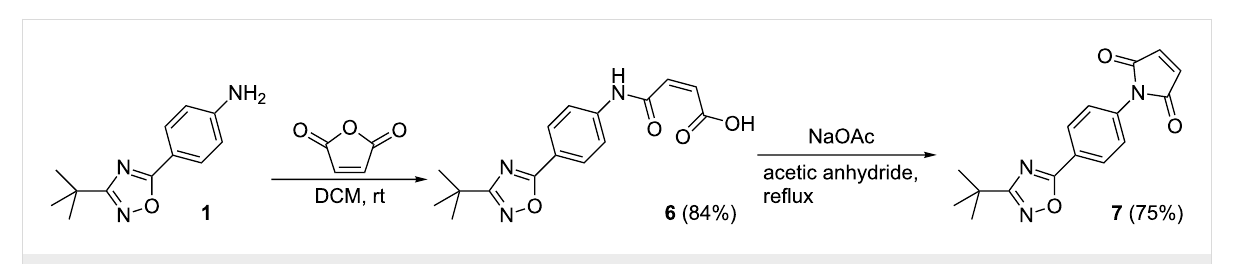
Scheme 5: Synthesis of 1-(4-(3- tert -butyl-1,2,4-oxadiazol-5-yl)phenyl)-1 H -pyrrole-2,5-dione ( 7 ).